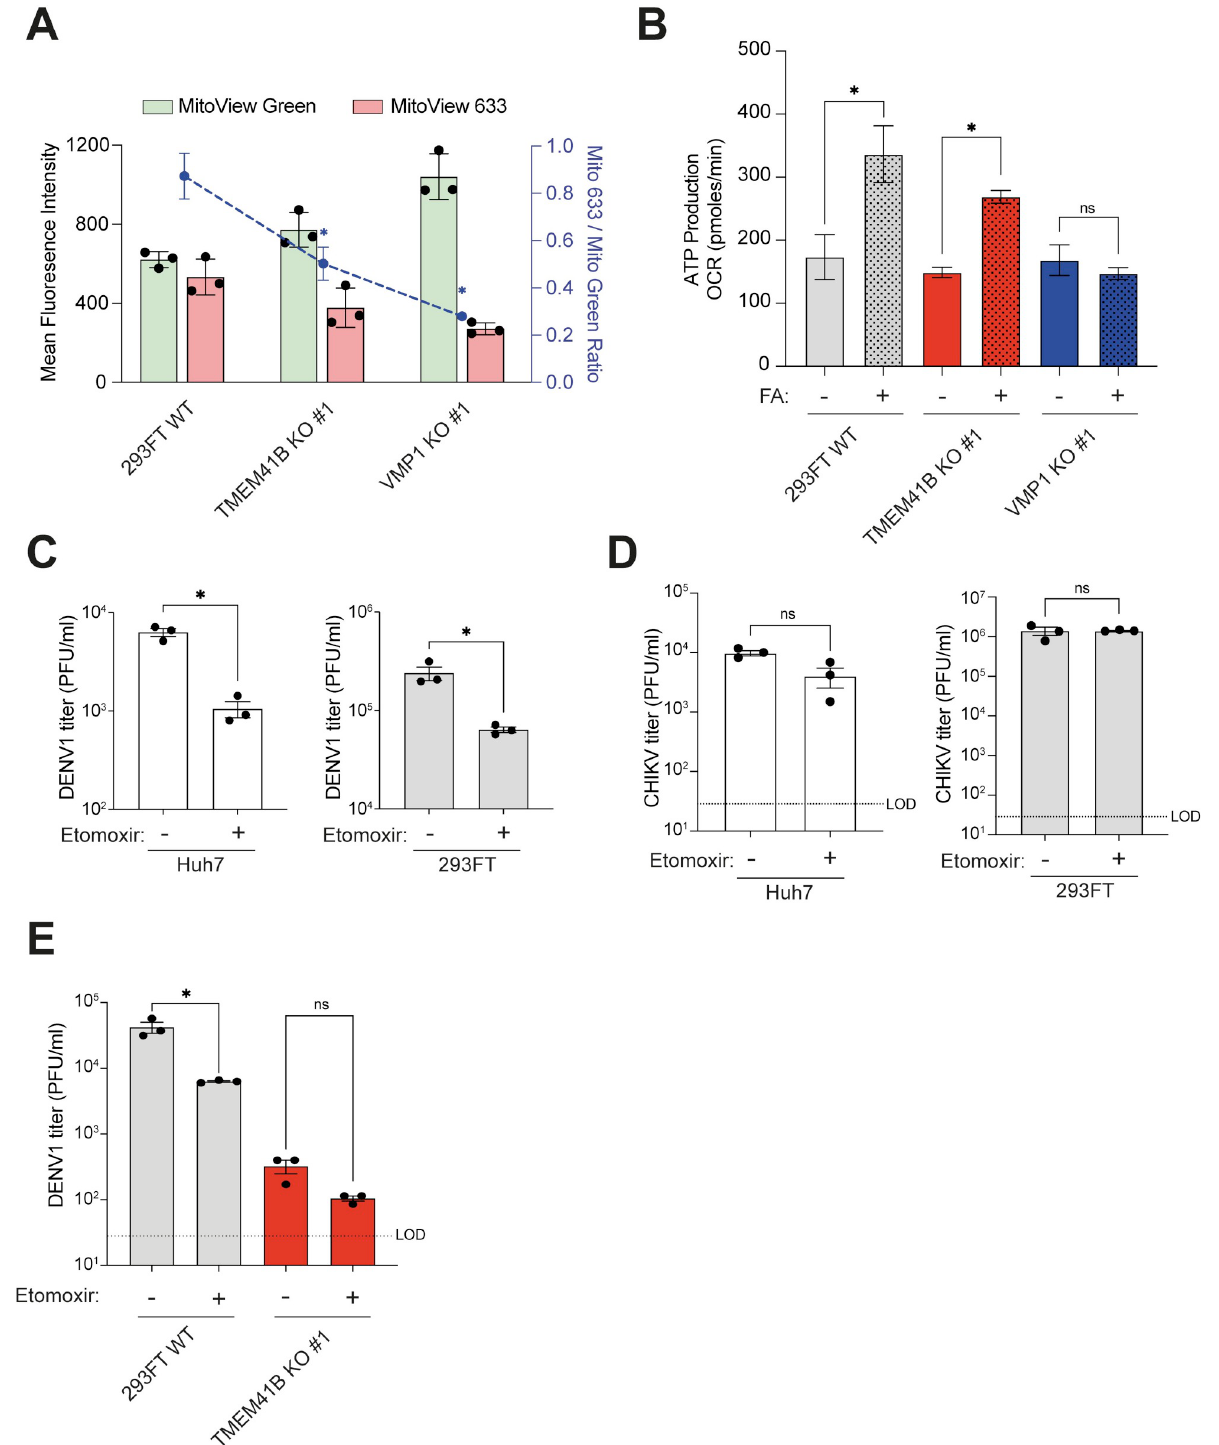
Fig 4. Impaired mitochondrial beta-oxidation contributes to reduced DENV infection in 293FT TMEM41B KO and VMP1 KO cells. (A) Comparison of total (MitoView Green) vs functionally active (MitoView 633) mitochondria level in 293 FT WT, TMEM41B KO clone #1, and VMP1 KO clone #1 cells. Blue dashed line indicates the ratio of MitoView 633 to MitoView Green signal level. (B) Beta-oxidation associated ATP production in the WT and clonal KO cells upon FA supplementation, measured by extracellular flux analysis. (C) Impact of Etomoxir treatment on production of infectious DENV particles in 293FT WT and Huh7 WT cells. Cells were infected with DENV1 at MOI of 1 and treated with 200 μ M Etomoxir for 48